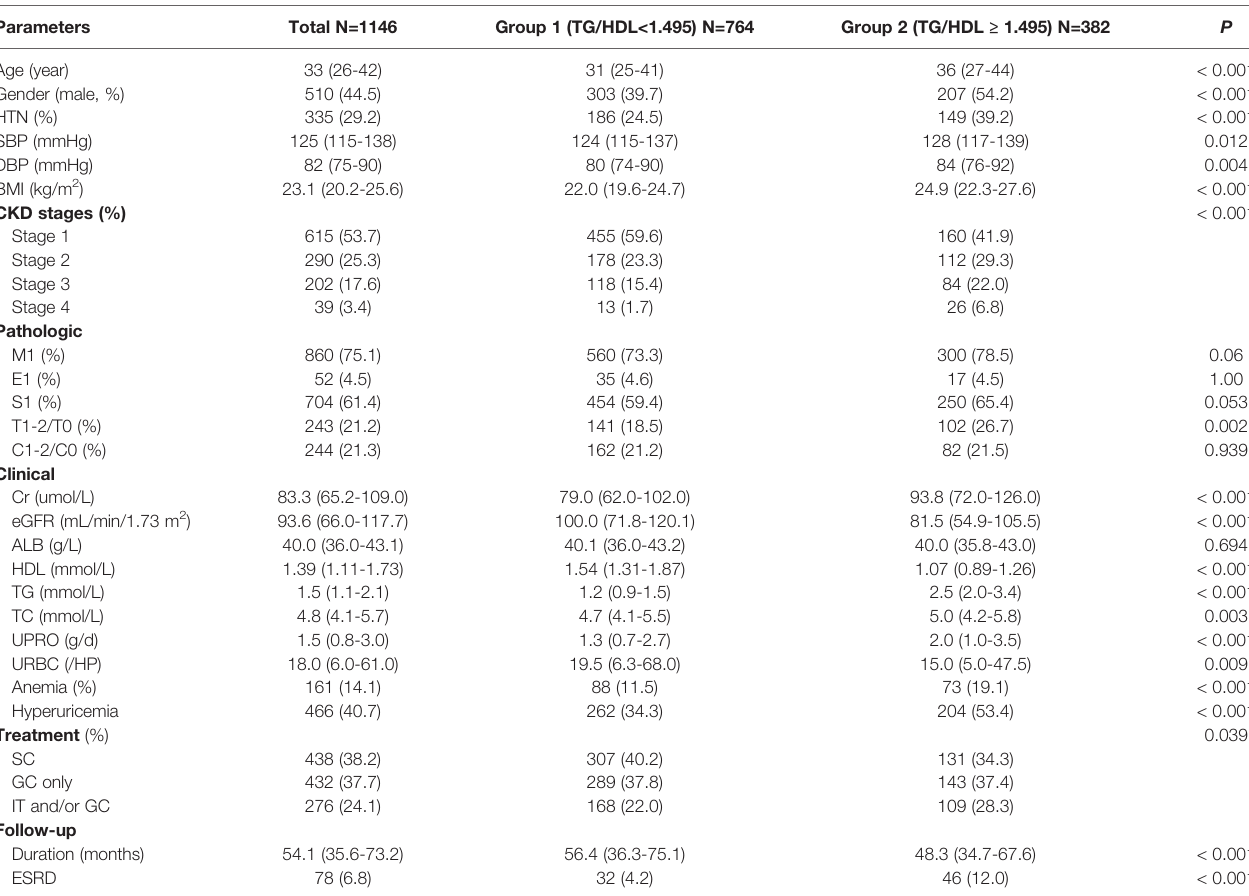
TABLE 1 | Demographic and clinicopathological characteristics of 1146 IgAN patients.